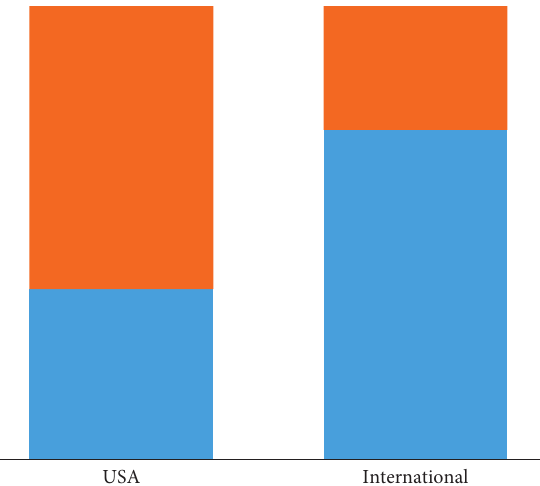
Figure 3: Percentage of studies where “fear of consequences” is an important barrier. Blue, yes, “fear of consequences” is an important barrier. Orange, no, “fear of consequences” is not an important